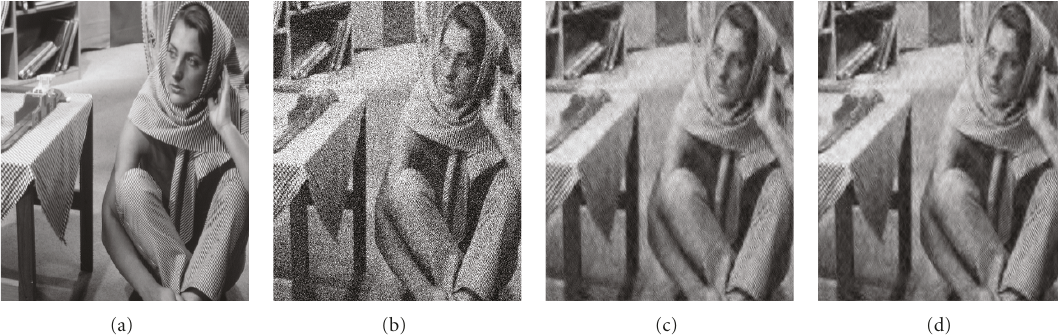
Figure 10: Subjective comparison for denoising performance, (a) original image, (b) noise image, (c) Po and Do’s result, and (d) our